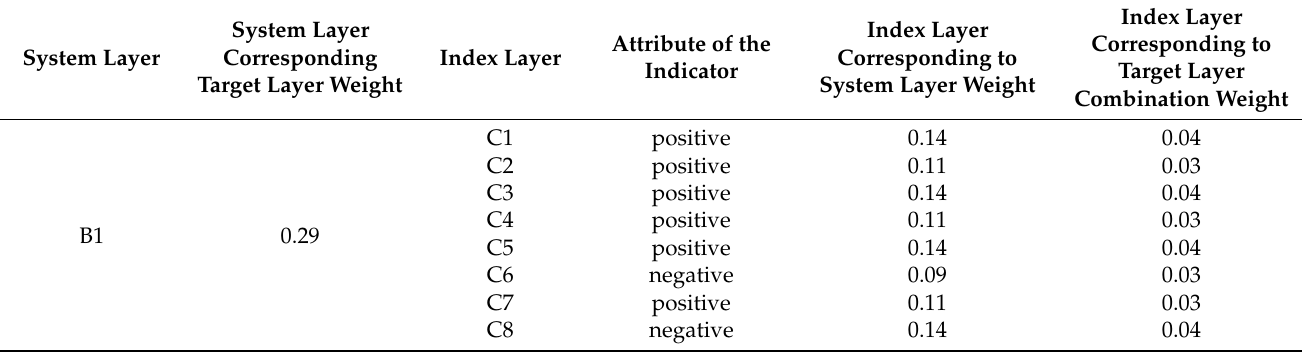
Table 5. Evaluation index weights for township